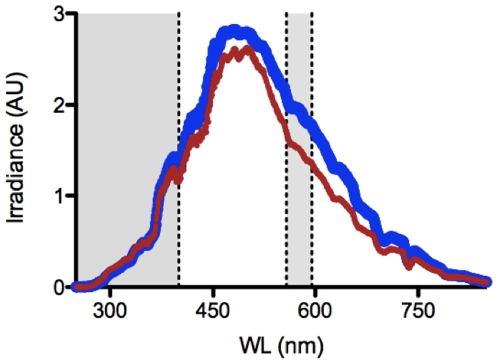
PTFE reflectance.Natural solar irradiance in arbitrary units reflected off PTFE (red) compared with downwelling irradiance (blue) measured between 200–850 nm at 0.3 nm intervals using a USB2000 spectrometer (Oceanoptics, USA). In the UV region a one to one correlation was found and over the visible wavelengths, reflectance was >95%. Shaded areas correspond to the UV peak (250–400 nm) and the visible peak (558–595 nm) used in this study.